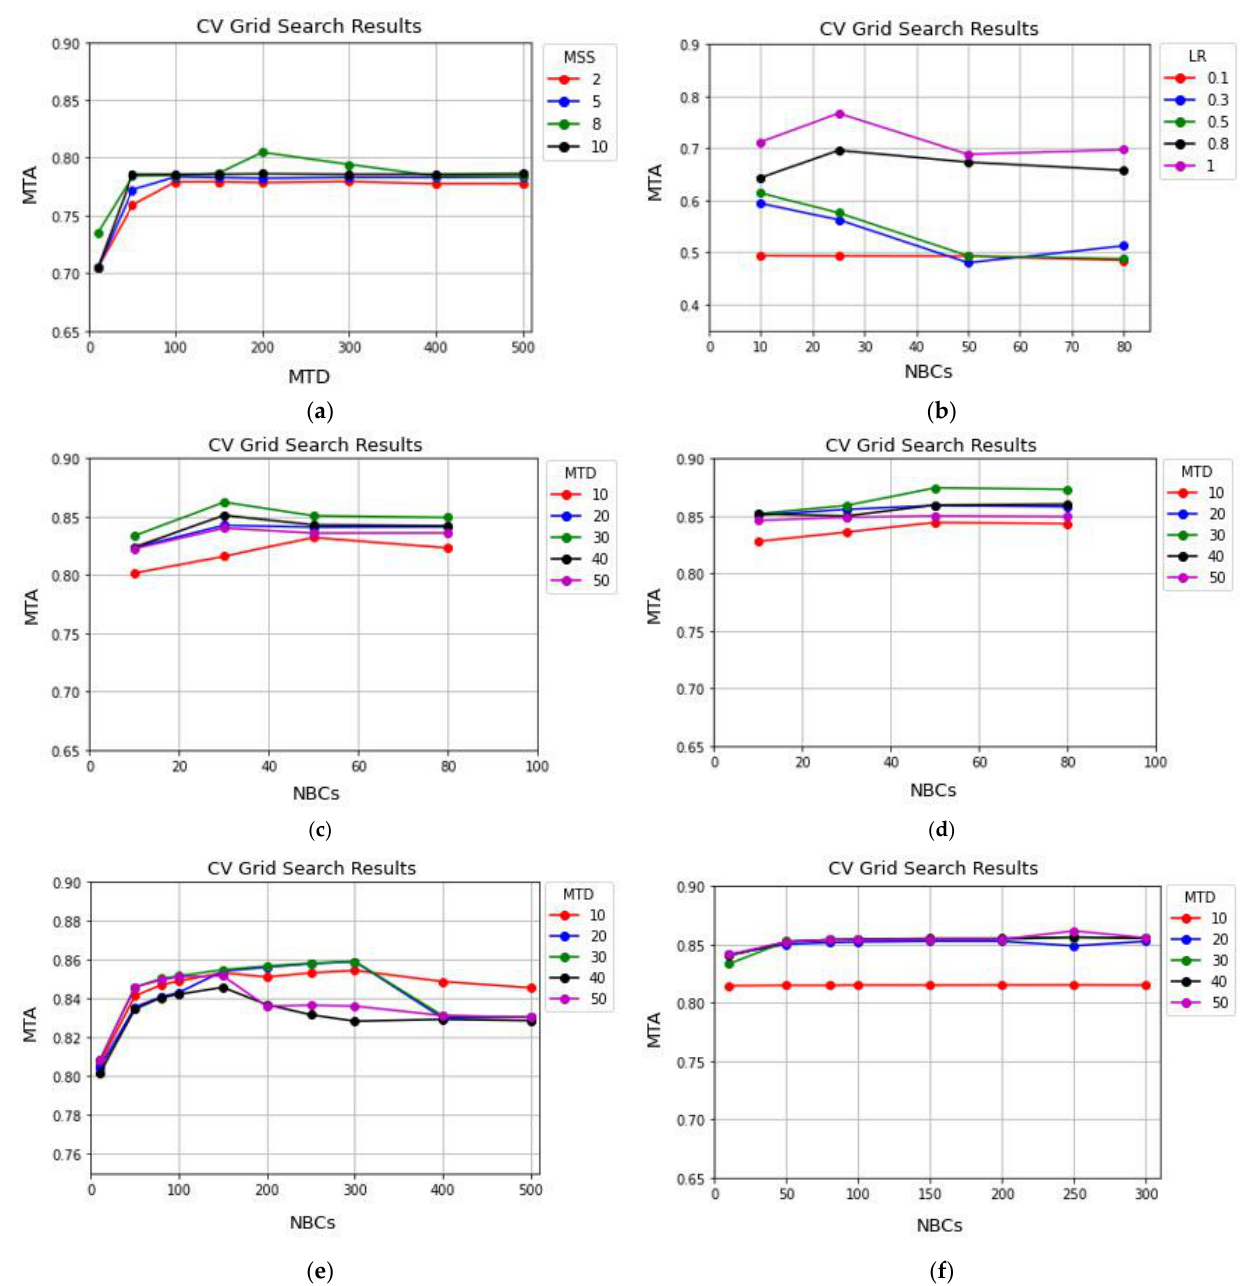
Figure 12. Hyper-parameter analysis of different EL methods using Pavia hyperspectral data. ( a ) DT, ( b ) AdaBoost, ( c ) GBM, ( d ) XGBoost, ( e ) LightGBM, and ( f ) RF.